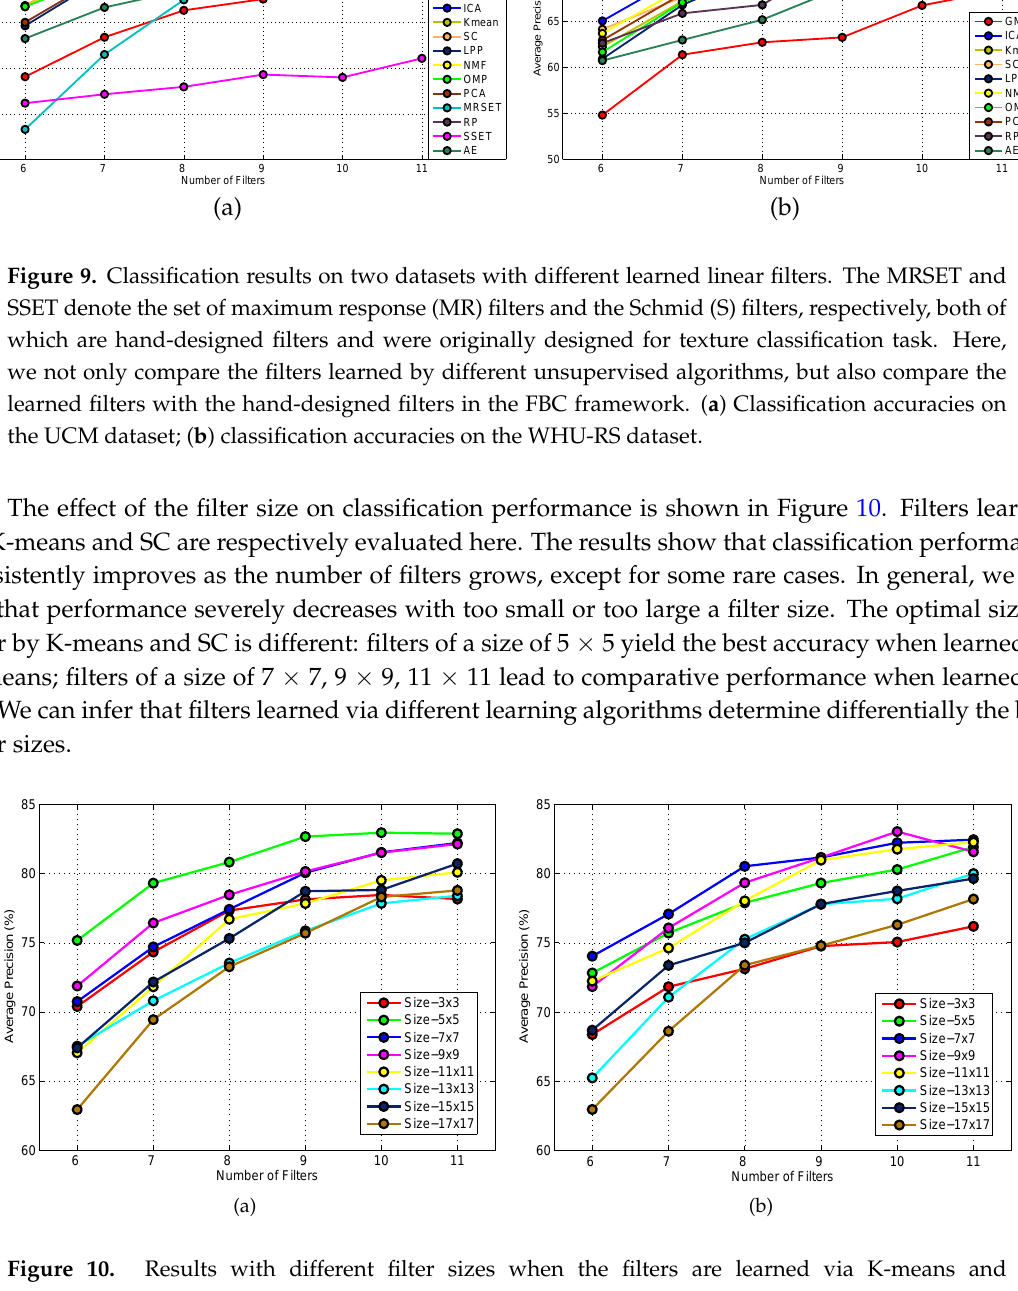
Figure 10. Results with different filter sizes when the filters are learned via K-means and sparse coding. ( a ) Classification results with K-means filters; ( b ) classification results with sparse coding